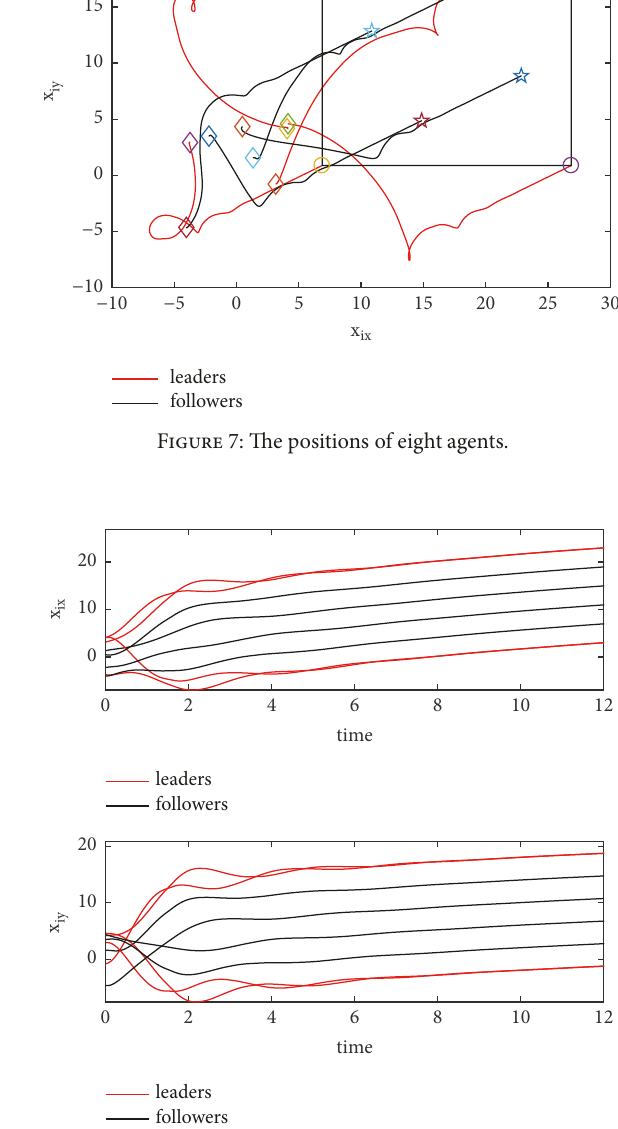
Figure 6: The inputs of eight agents.